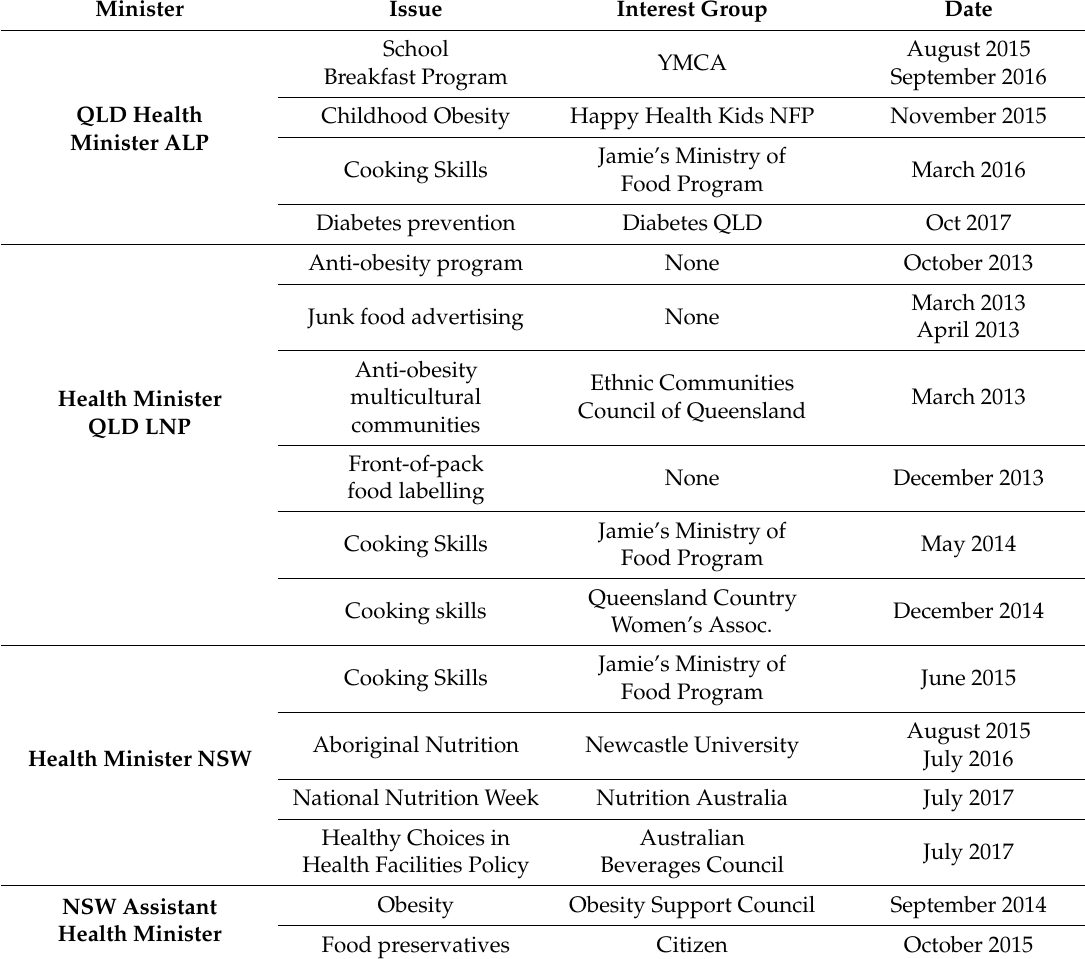
Table 5. Specific nutrition related issues documented in health ministers’ diaries (January 2013–June